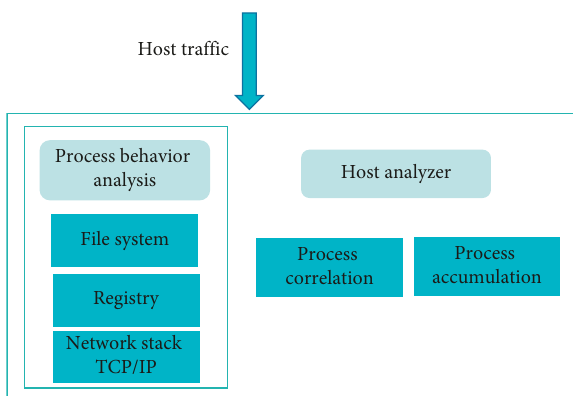
Figure 7: Host analyzer